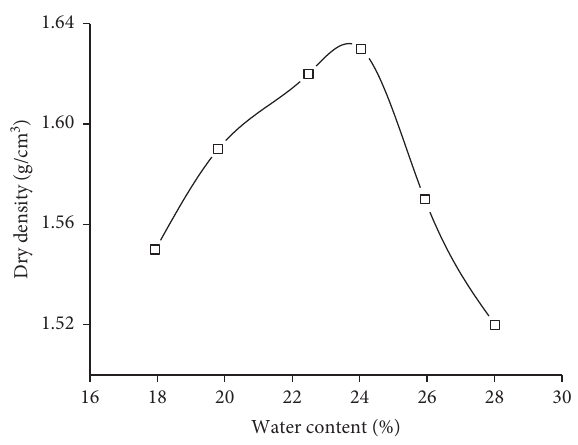
Figure 2: Compaction curve of the tested